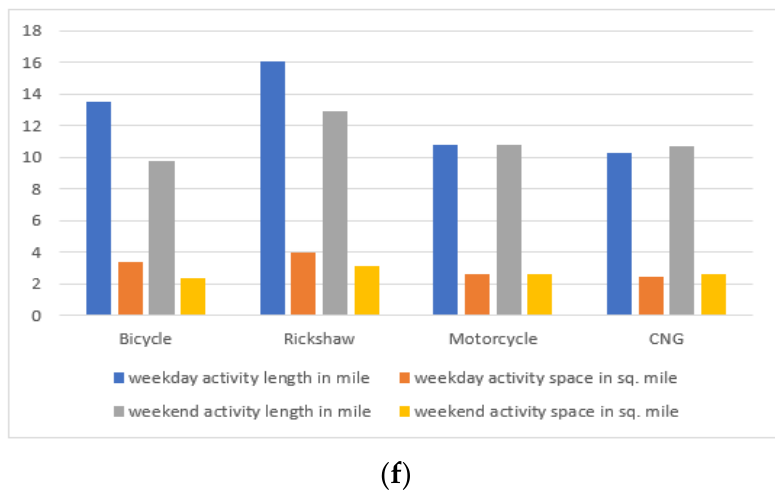
Figure 16. The weekday-to-weekend variability of household activity space indices. ( a ) AS values by HH size; ( b ) AS values by study sub-areas; ( c ) AS values by presence of children in household from di ff erent age categories; ( d ) AS values by car ownership status; ( e ) AS values by number of cars used; ( f ) AS values by another vehicle ownership.